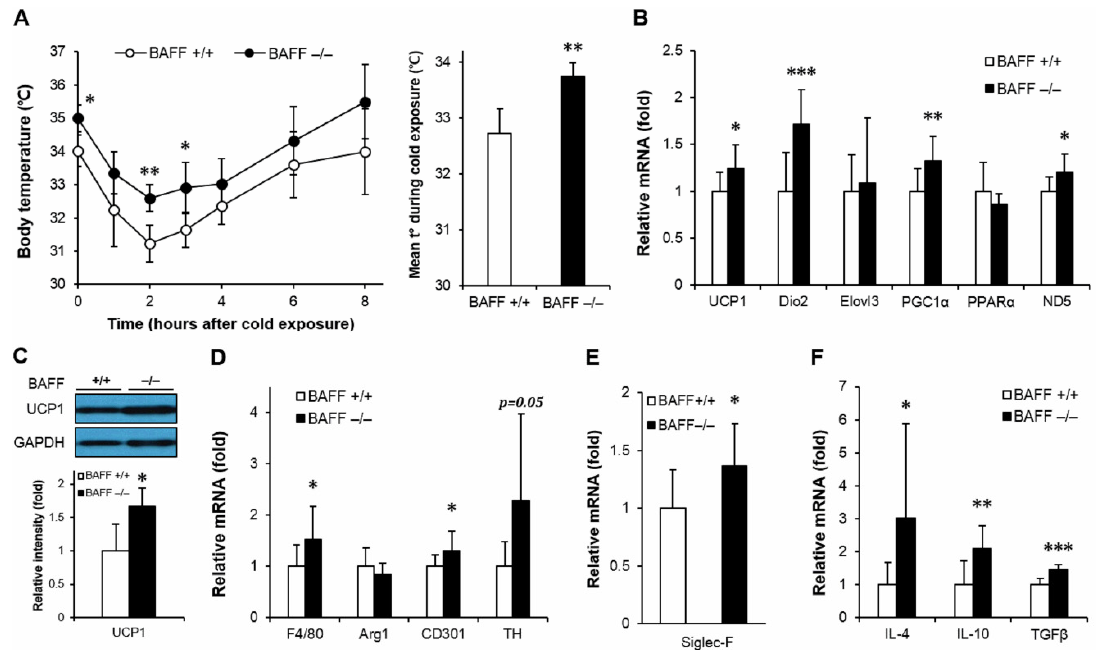
Figure 2. BAFF depletion supports uncoupling protein 1 (UCP1)-dependent thermogenesis and alternative macrophage activation in brown adipose tissue. ( A ) Body core temperature of 10-month-old wild-type or BAFF − / − mice. Measurements were performed at 0, 1, 2, 3, 4, 6 and 8 h during cold exposure at 4 ◦ C ( n = 4–5). ( B ) E ff ect of BAFF deficiency on thermogenic program gene expression ( n = 9–12). Gene expression level is normalized with mRNA expression level of Arbp. ( C ) E ff ect of BAFF deficiency on UCP1 protein expression level ( n = 4–5). Proteins were extracted from the tissue for SDS-PAGE-immunoblot analysis. E ff ect of BAFF deficiency on the expression of genes involved in ( D ) M2-like macrophage activation, ( E ) mature eosinophil cell marker and ( F ) anti-inflammatory cytokines ( n = 9–12). Data represent means ± SD. * p < 0.05, ** p < 0.01, *** p < 0.001 between wild-type and BAFF − / − mice.